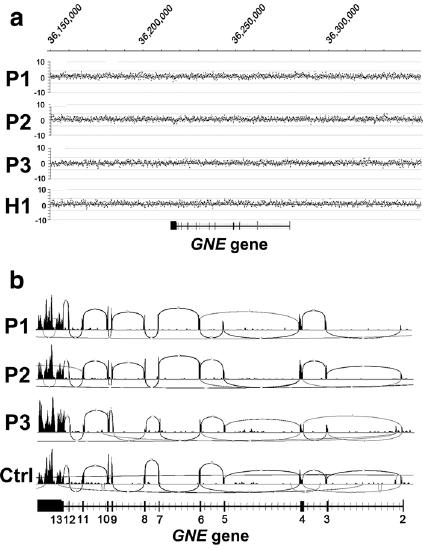
Figure 2. CNV analysis of GNE and structure of the GNE transcript in skeletal muscles from c.620A>T homozygotes. ( a ) XHMM plot of chr9: 36,000,000–38,000,000. No large deletions or insertions were found in GNE in P1–3 or H1. ( b ) Sashimi plots of GNE transcripts in skeletal muscle showing that there were no structural variants in